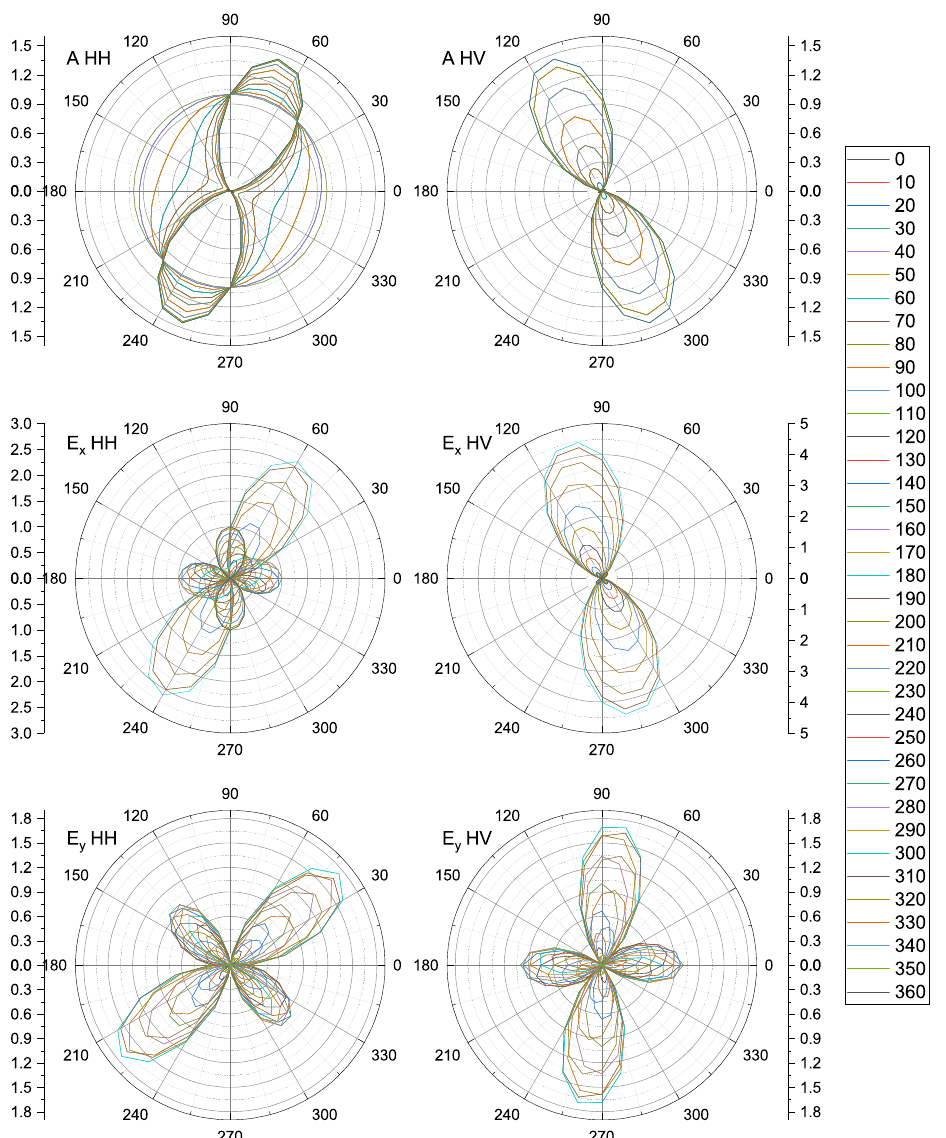
Figure A3. Calculated intensity dependence of Raman modes in the HH and HV polarisation on rotation angle in plane. The angle to z -axis is 90